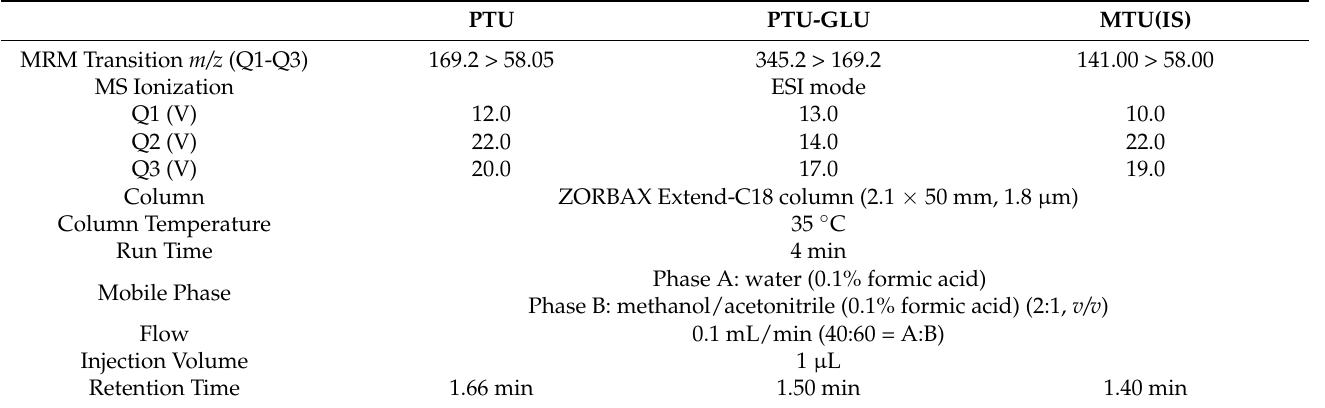
Table 1. Summary of HPLC-MS/MS